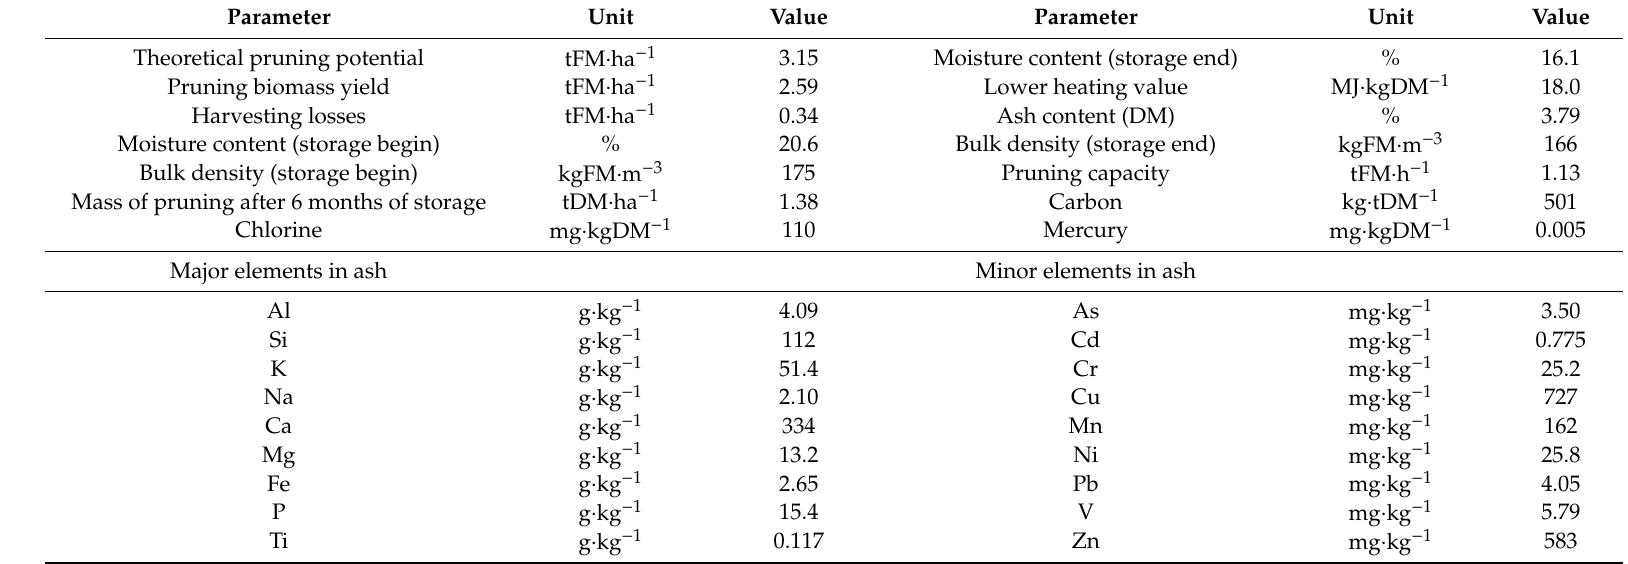
Table 2. Peach orchard and pruning characteristics. FM—fresh mass, DM—dry